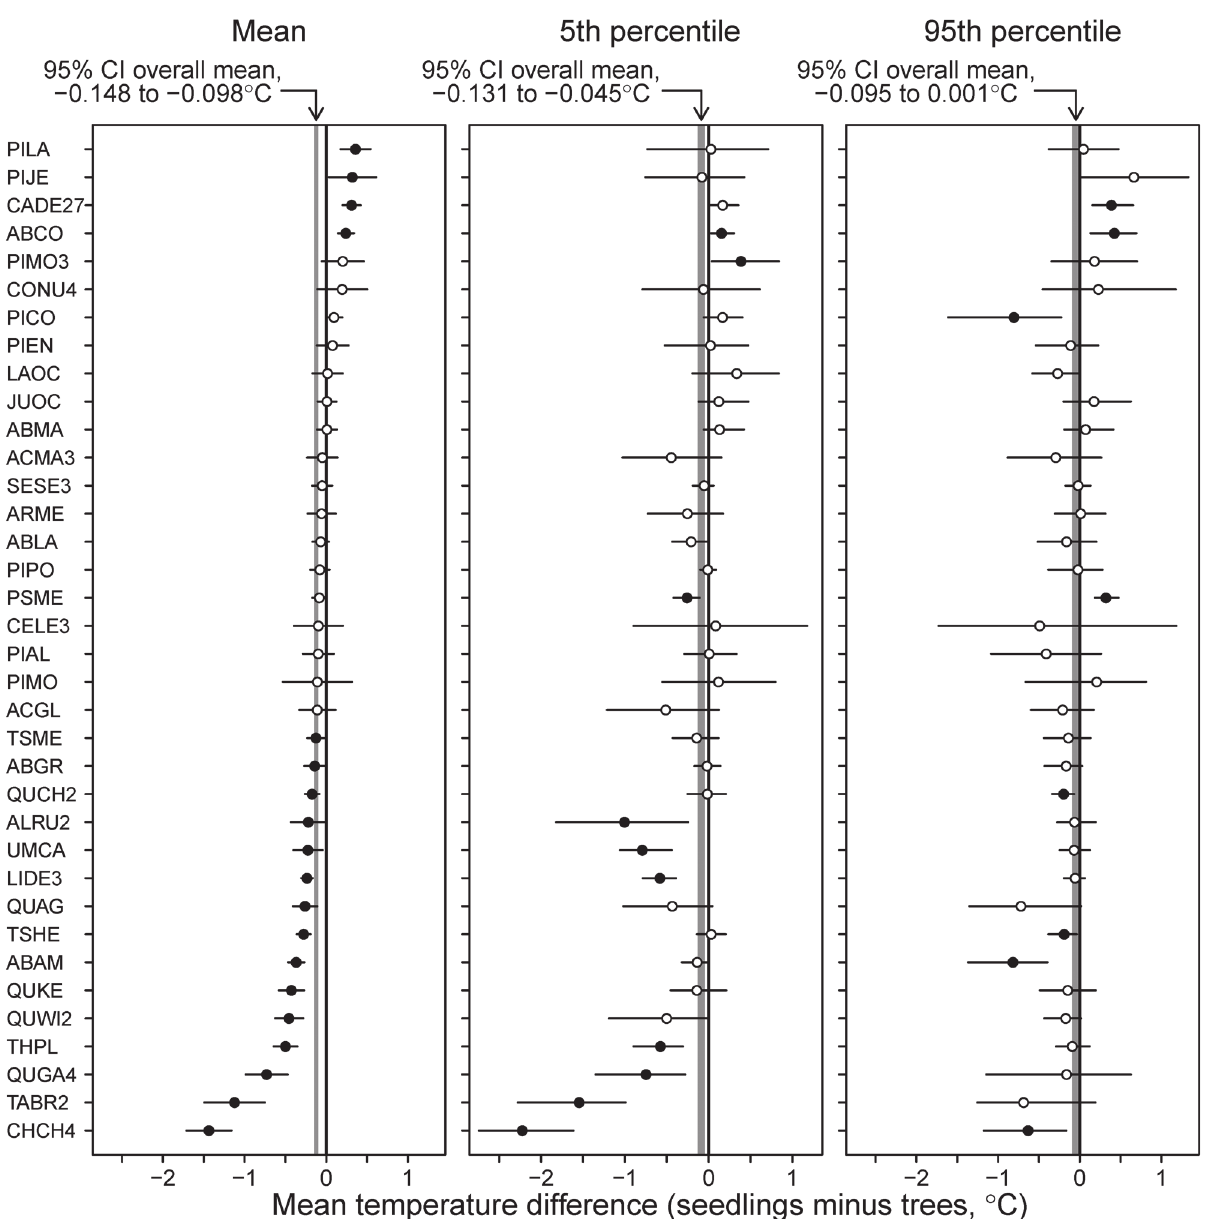
Fig 7. Difference between the mean and percentiles of the temperature distribution of seedlings and that of mature trees. A positive number indicates that the mean temperature of the seedling range is warmer than that of trees. The circles represent the estimated difference for each species and the horizontal lines represent 95% confidence intervals for the difference. Solid circles indicate that the 95% CI does not include 0 (difference significant at the 0.05 level), open circles indicate that the 95% CI includes 0. The gray band is a 95% confidence interval for the overall mean difference, across all species. Only species present at more than 100 plots as seedlings and as trees are included. Species name codes listed in Table